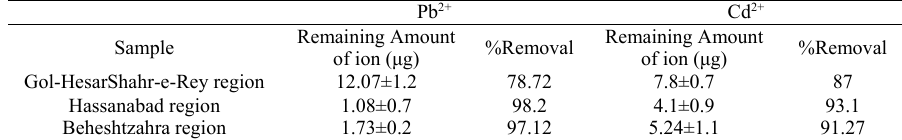
Table 3. Results of Pb 2+ and Cd 2+ ions removal by zeolite N.P./PEG/GO nano-composite in the actual samples